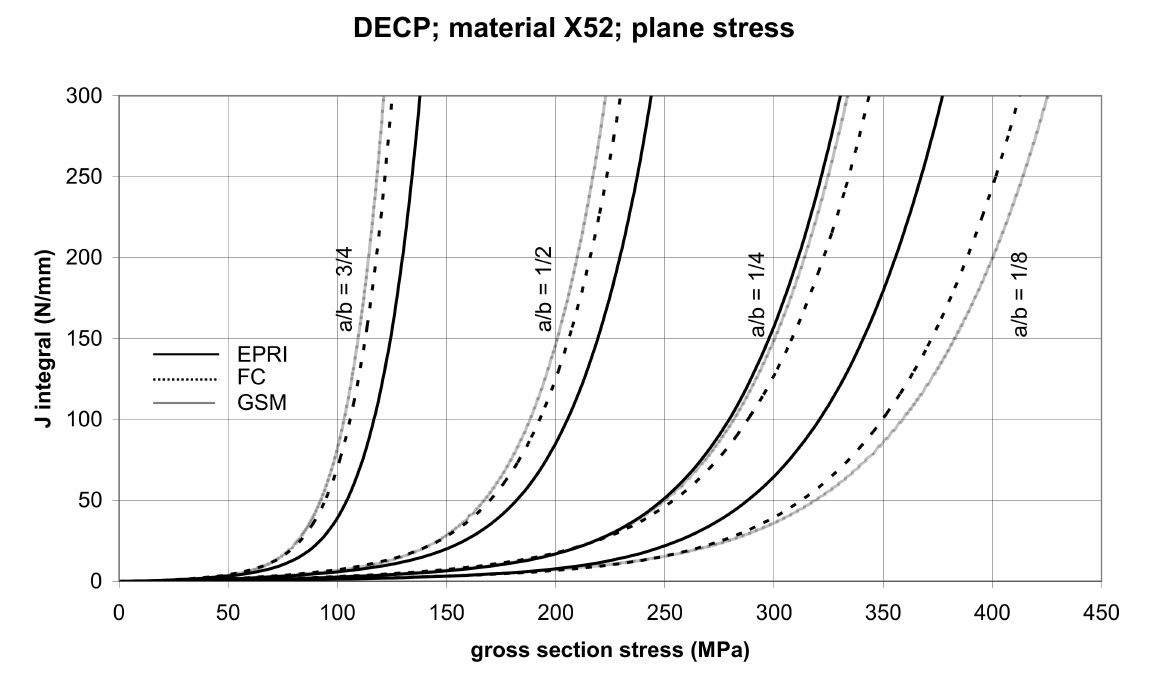
Figure 10. Comparison of J integral for DECP X52 steel specimens in the plane stress condition as determined by the EPRI, GSM, and FC methods.